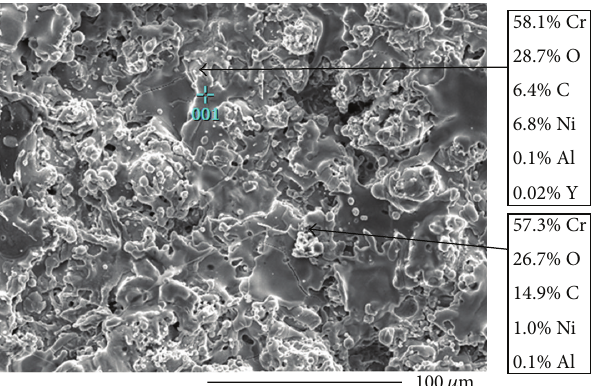
Figure 3: Typical morphology of the cermet coated